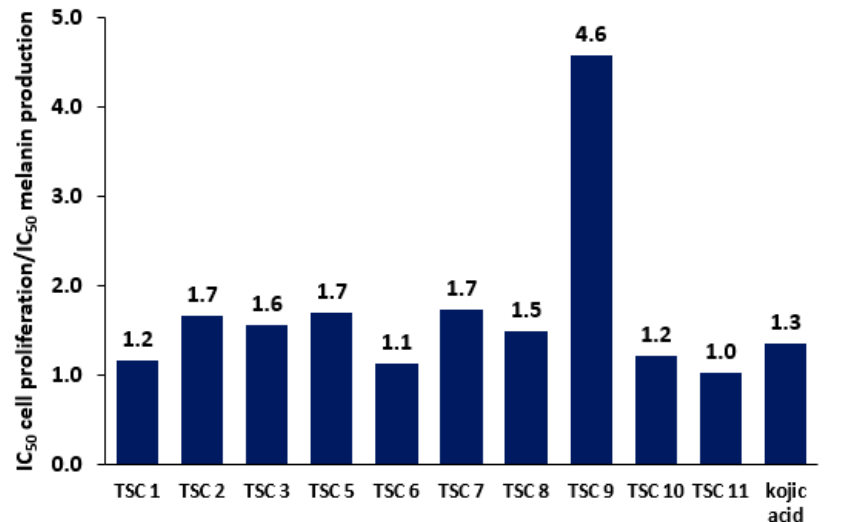
Figure 7. Ratio of IC 50 for the inhibition of B16F10 cell proliferation to IC 50 for the inhibition of melanin production.